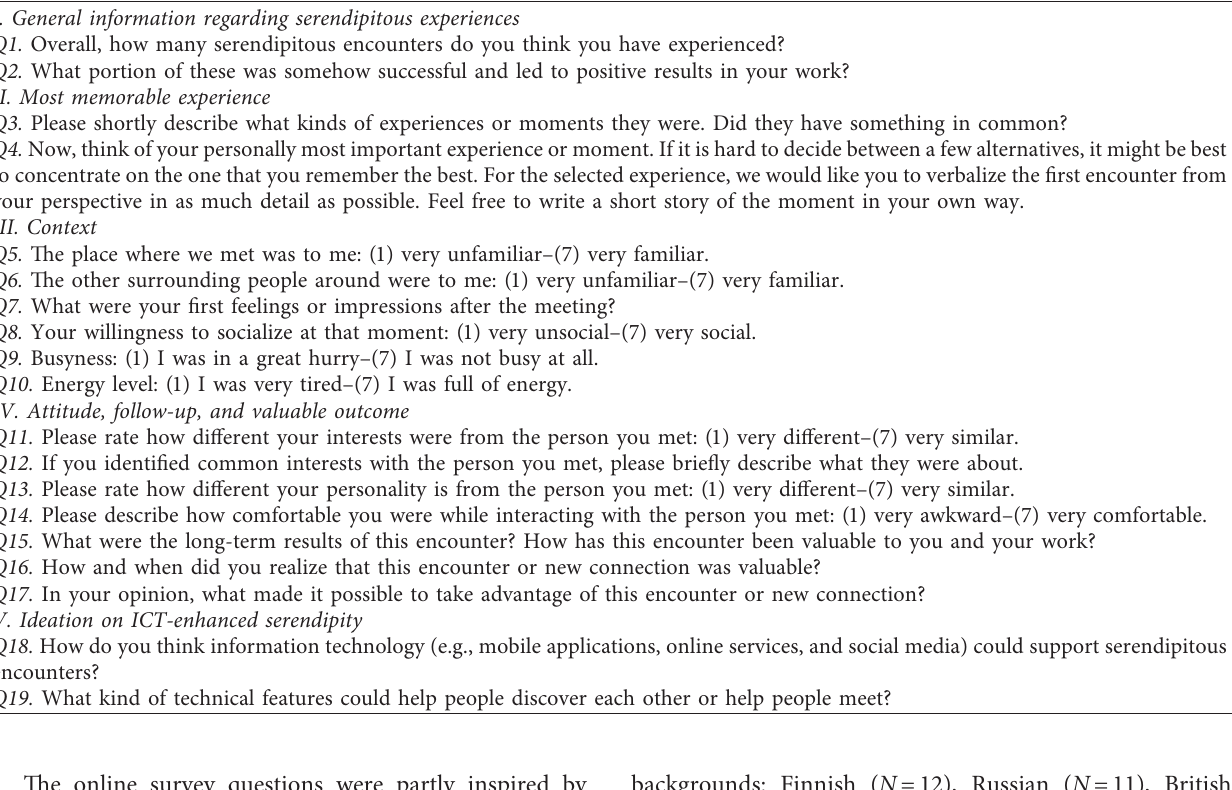
Table 2: Online survey structure and verbatim